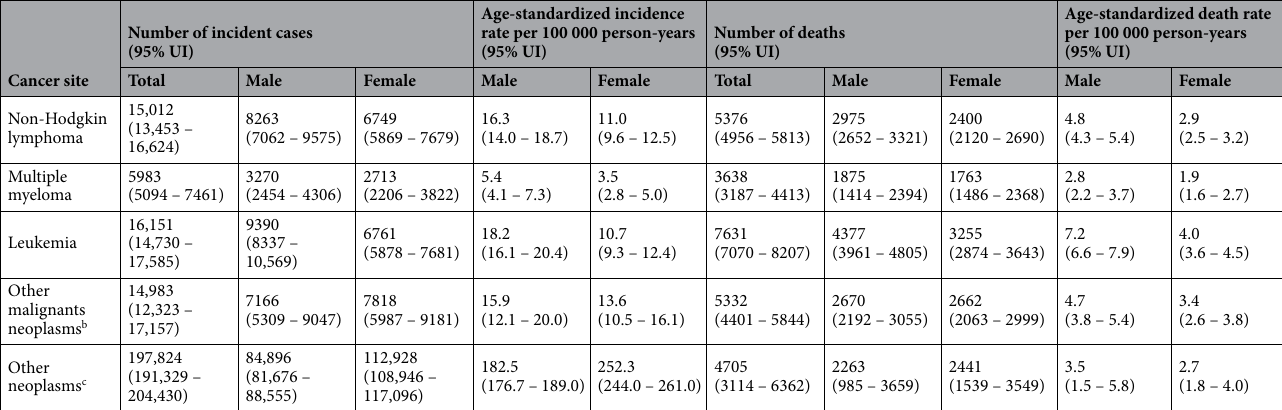
Table 1. Incidence, deaths, and corresponding age-standardized rates for all cancers and 30 cancer groups. Italy, 2017. UI: uncertainty intervals. a Includes malignant neoplasms (International Classification of Diseases 10 [ICD-10] codes C00-C96, excluding Kaposi sarcoma, ICD-10 C46), benign/in situ neoplasms (ICD-10 D00-D49), and other malignant neoplasms (ICD-10 codes C17, C30-C31, C37, C38, C40-C41, C47-C49, C4A, C51-C52, C57-C58, C60, C63, C66, C68, C69, C74-C75). b Includes other malignant neoplasms (ICD-10 codes